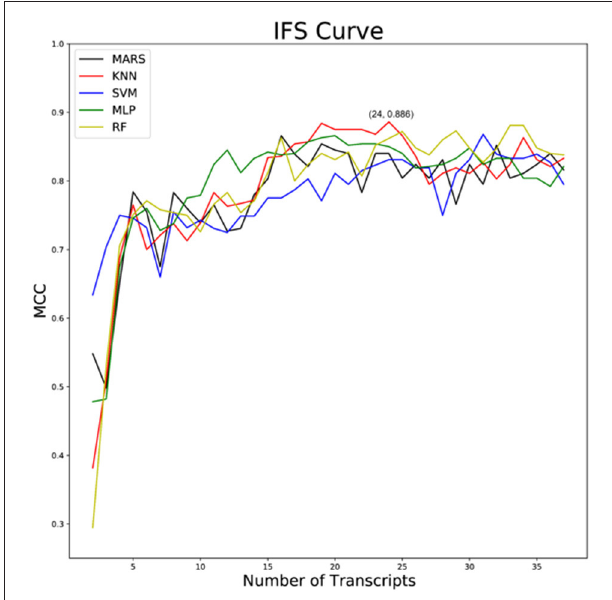
FIGURE 1 | IFS curves of MARS, KNN, SVM, MLP, and RF classifiers. Black: MARS classifier; red: KNN classifier; blue: SVM classifier; green: MLP classifier; brownish-yellow: RF classifier; horizontal ordinate indicates the number of classifier genes and vertical ordinate represents MCC